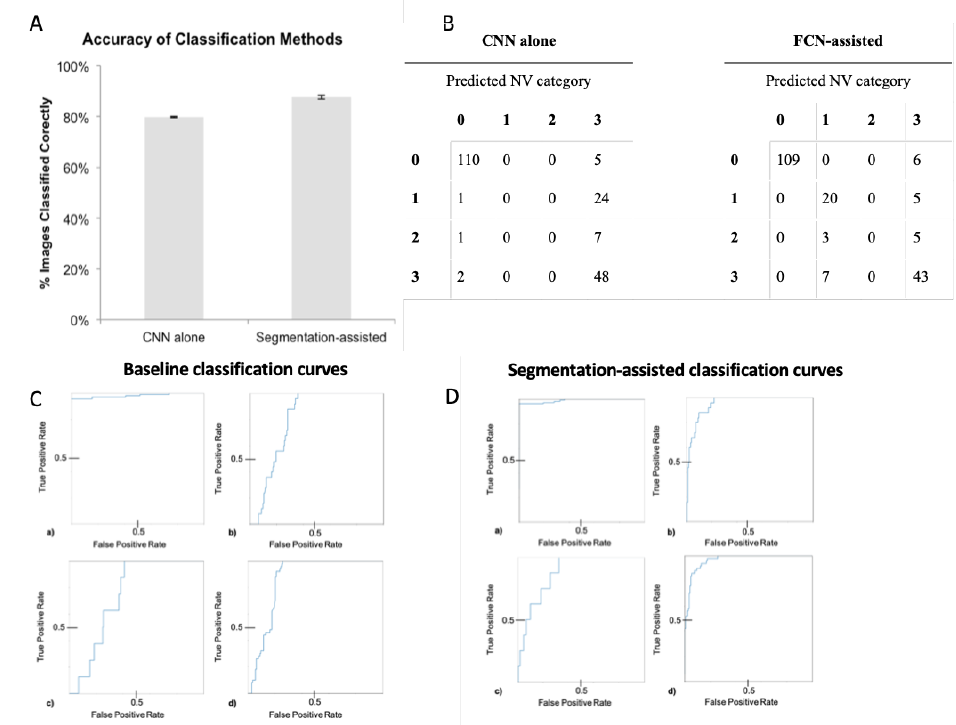
Figure 4. Performance analysis. ( A ) Average classification accuracy across three trials. The graph shows mean classification accuracy from three trials using CNN alone (79.97%, SD = 2.92%), compared to mean accuracy from three trials using segmentation-assisted classification (87.71%, SD = 7.71%). Error bars show ±SD; ( B ) Confusion matrix of image classification results; ( C ) Receiver operating characteristic (ROC) curves for classification by CNN alone. Four ROC curves are depicted; one for each classification category of DR: (a) Non-proliferative DR (area under the curve, AUC = 0.98), (b) Evidence of past NV (AUC = 0.8), (c) Ambiguous (AUC = 0.74), and (d) Proliferative DR with active NV (AUC = 0.86). ( D ) ROC curves for segmentation-assisted classification. Four ROC curves are depicted; one for each classification category of DR: (a) NPDR (AUC = 0.90), (b) Evidence of past NV (AUC = 0.95), (c) Ambiguous (AUC = 0.87), and (d) PDR with active NV (AUC = 0.97). The true positive rate is equivalent to sensitivity. The false positive rate is equivalent to 1 — specificity.